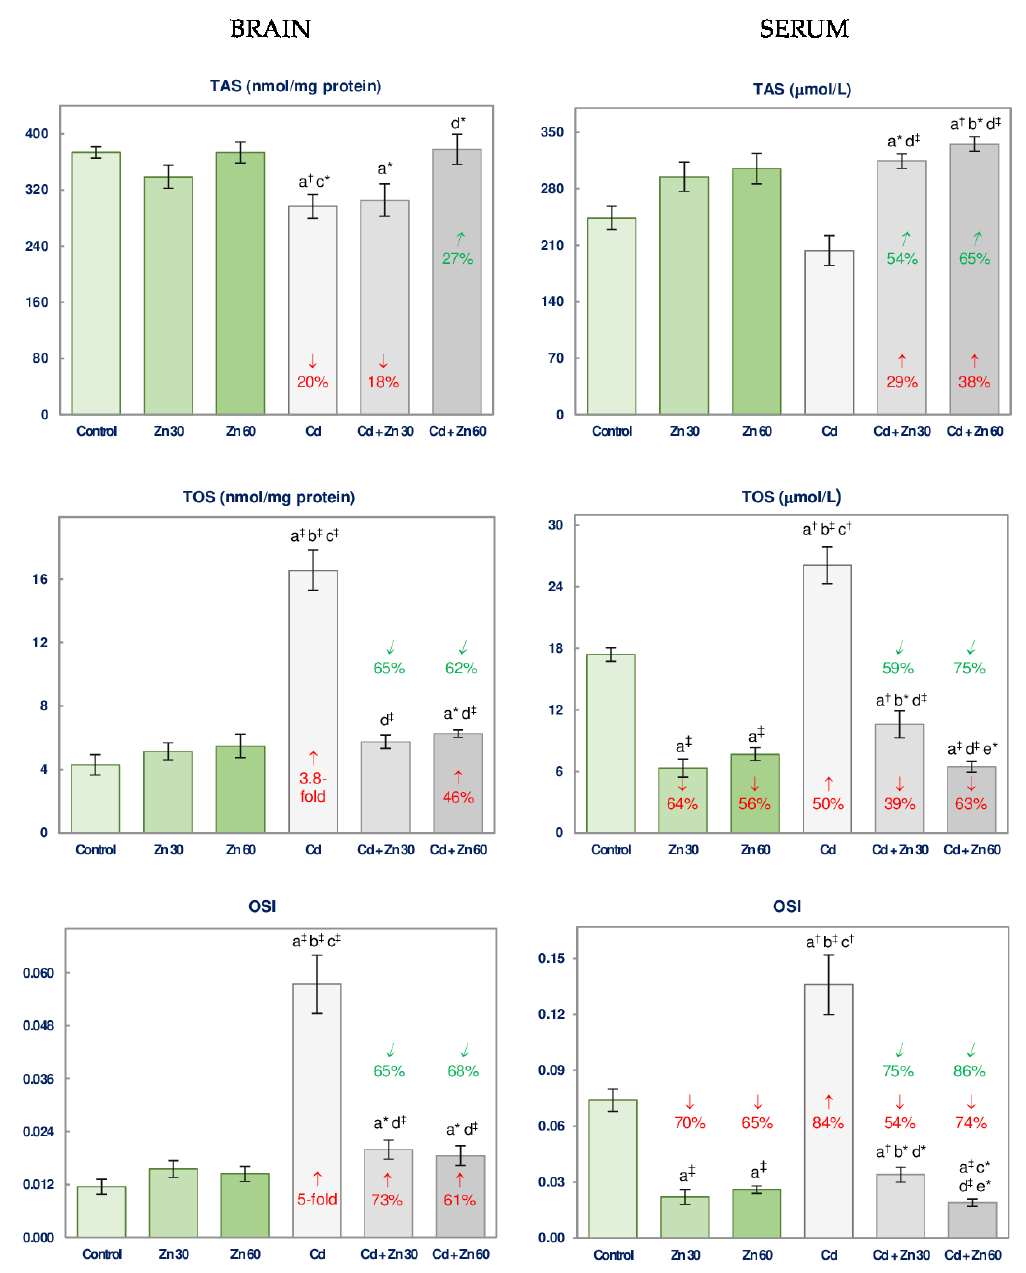
Figure 5. Total antioxidative status (TAS), total oxidative status (TOS), and oxidative stress index (OSI) in the brain tissue and serum of male rats after 6-month treatment with cadmium (5 mg Cd/L) and/or zinc (30 or 60 mg Zn/L) via drinking water. Data are shown as mean ± standard error (SE) for 8 animals. Statistically significant differences: a vs. Control group; b vs. Zn 30 group; c vs. Zn 60 group; d vs. Cd group; e vs. Cd + Zn 30 group; * p < 0.05; † p < 0.01; ‡ p < 0.001. The values inside the bars (or above them) express the percentage changes or folds of changes vs. the control group ( ↓ , decrease; ↑ , increase) or Cd group ( ↙ , decrease; ↗ , increase).